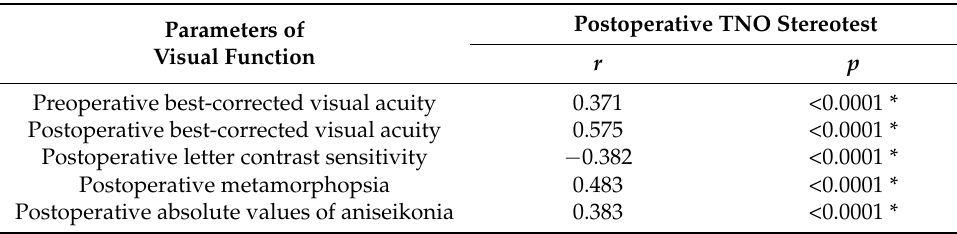
Table 3. Correlation between TNO stereotest results and other visual functions after retinal detach- ment surgery.